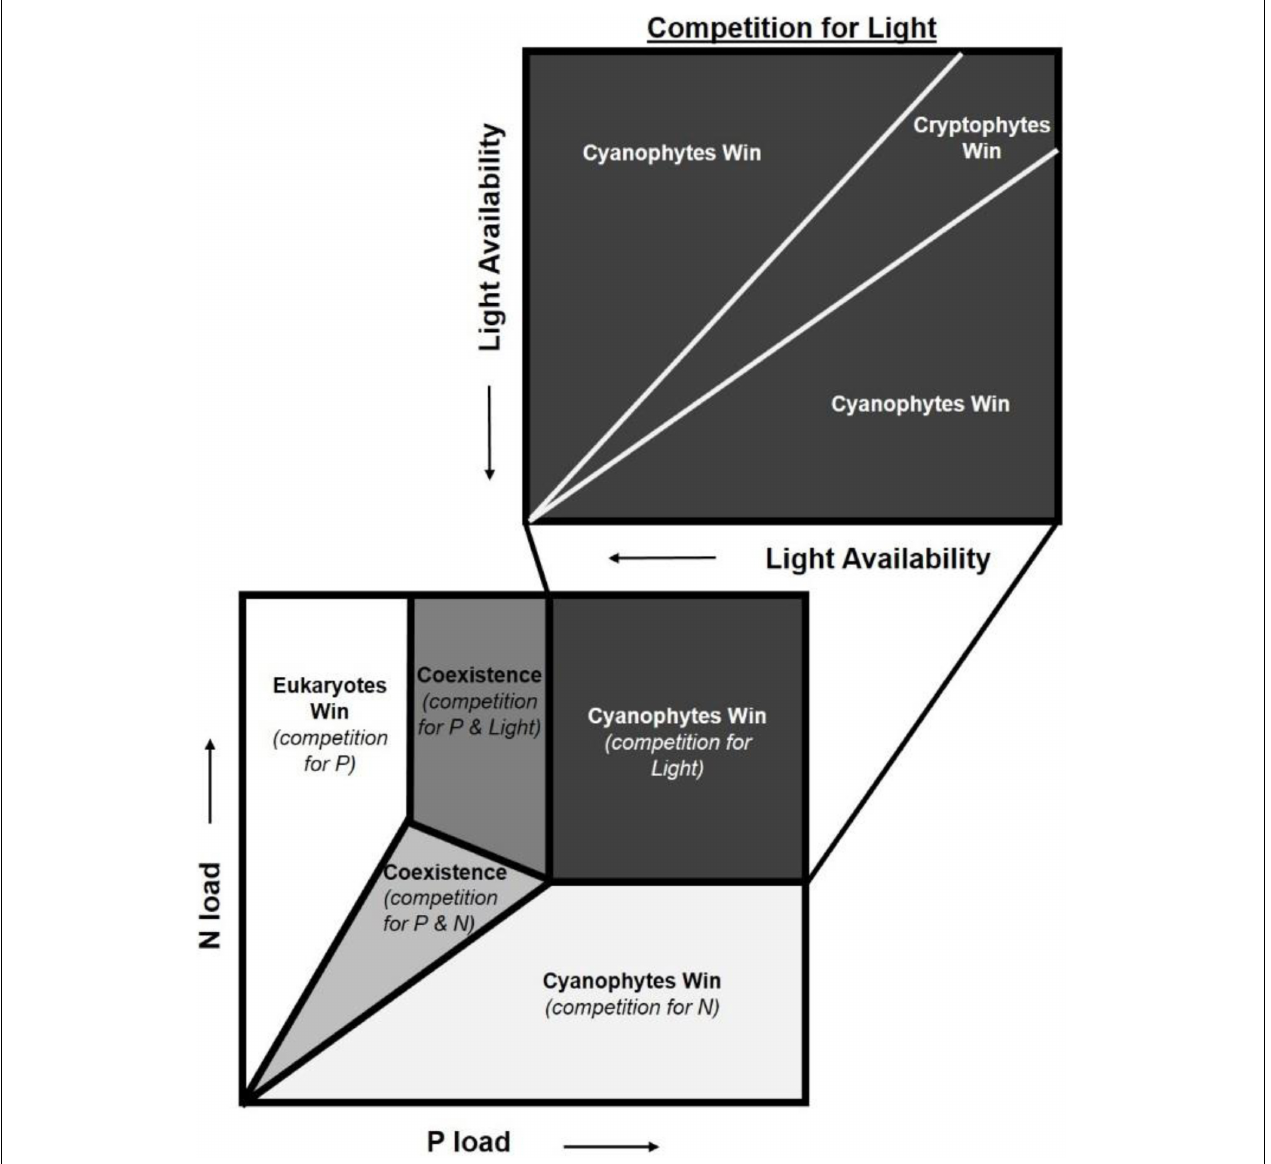
FIGURE 5 | Adaptation of the nutrient load hypothesis from Brauer et al. (2012). This hypothesis predicts which phytoplankton dominate based on competition for nitrogen (N), phosphorus (P), and light. The nutrient load hypothesis is based on the assumption that cyanobacteria are superior competitors for light and are able to dominate when N and P concentrations are high (Brauer et al., 2012). We add an additional box to highlight the nuance that functional traits can add to competition for these resources, specifically light. While cyanobacteria often dominate when light is the limiting resource, our findings suggest that cryptophytes can outcompete cyanobacteria under specific light levels due to functional